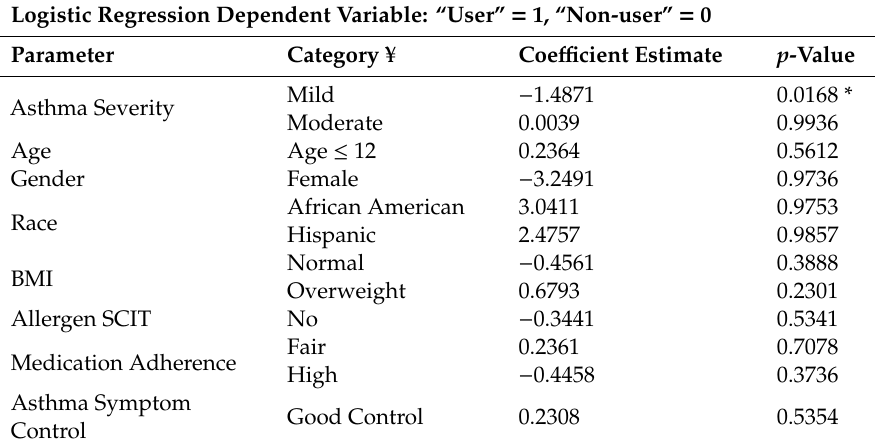
Table 3. Summary of results from logistic regression analysis.